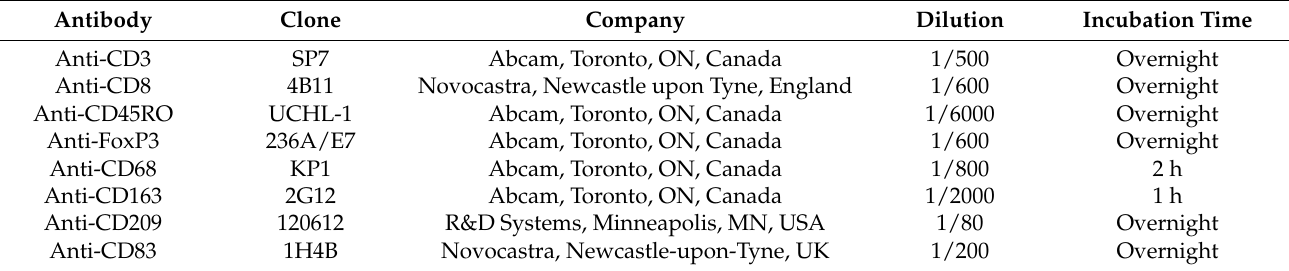
Table 1. Primary antibodies used in this